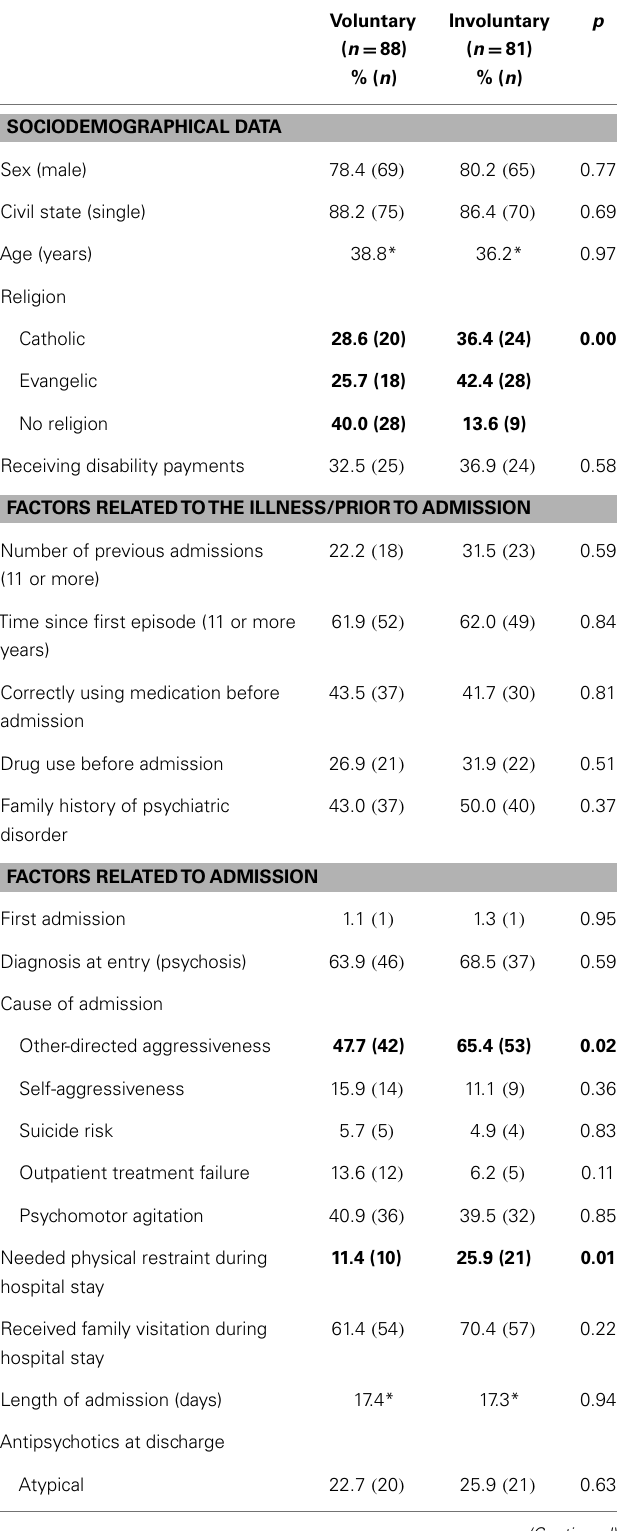
Table 1 | Sample characteristics according to admission status ( n = 169)